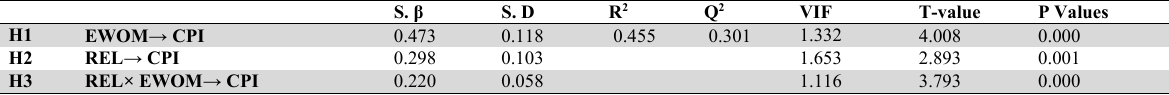
Fig. 3 . Moderation Effect of REL on the Relationship between e-WOM and CPI Structural